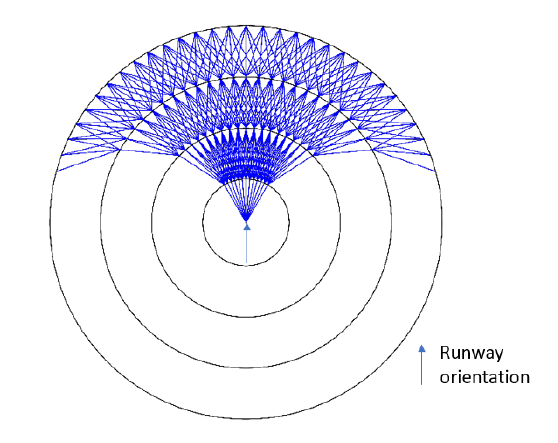
Figure 1. An example of discretization and graph construction (Five layers, one vertex every 5 ◦ , θ max = 30 ◦ ).